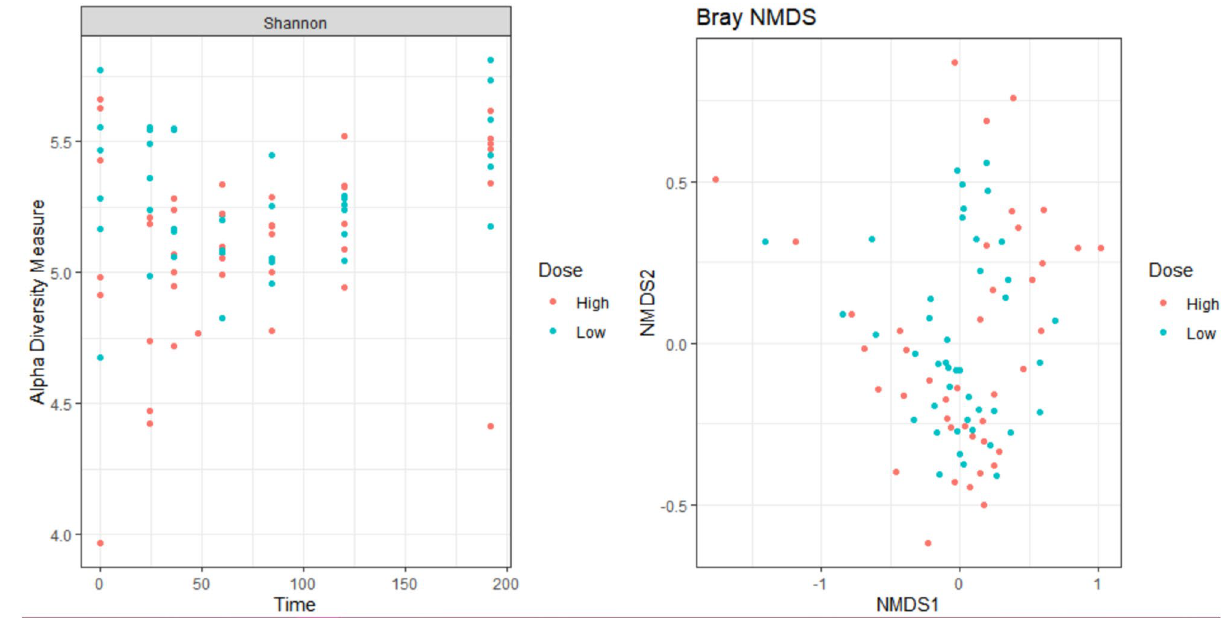
Figure 8. Shannon Diversity Index and Bray–Curtis plot assessing beta diversity . This is a Shannon Index diversity plot comparing the diversity of the samples between the high (orange) and low dose (blue) group. The higher the value on the y axis indicates there is more diversity in the microbial community. This is a Bray–Curtis plot to assess the beta diversity, or look at the variance across all the samples. The high dose group samples are shown in orange and the low dose group samples are shown in blue. The Bray–Curtis plot measures how dissimilar the samples are.